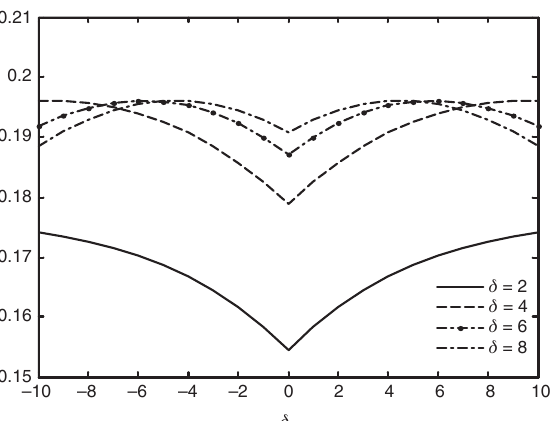
= 0 and Ω = 5. when δ 2 1 0